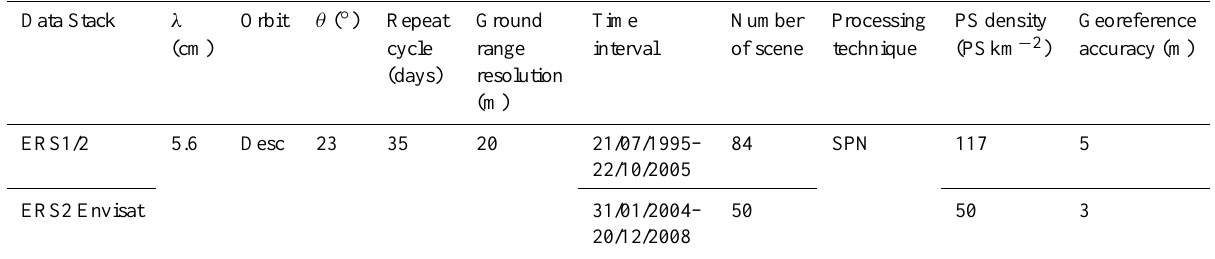
Table 2. Main characteristics of the processed data stacks of the westernmost sector of Vega Baja of the Segura River: λ , wavelength; θ , look angle; Desc, descending.